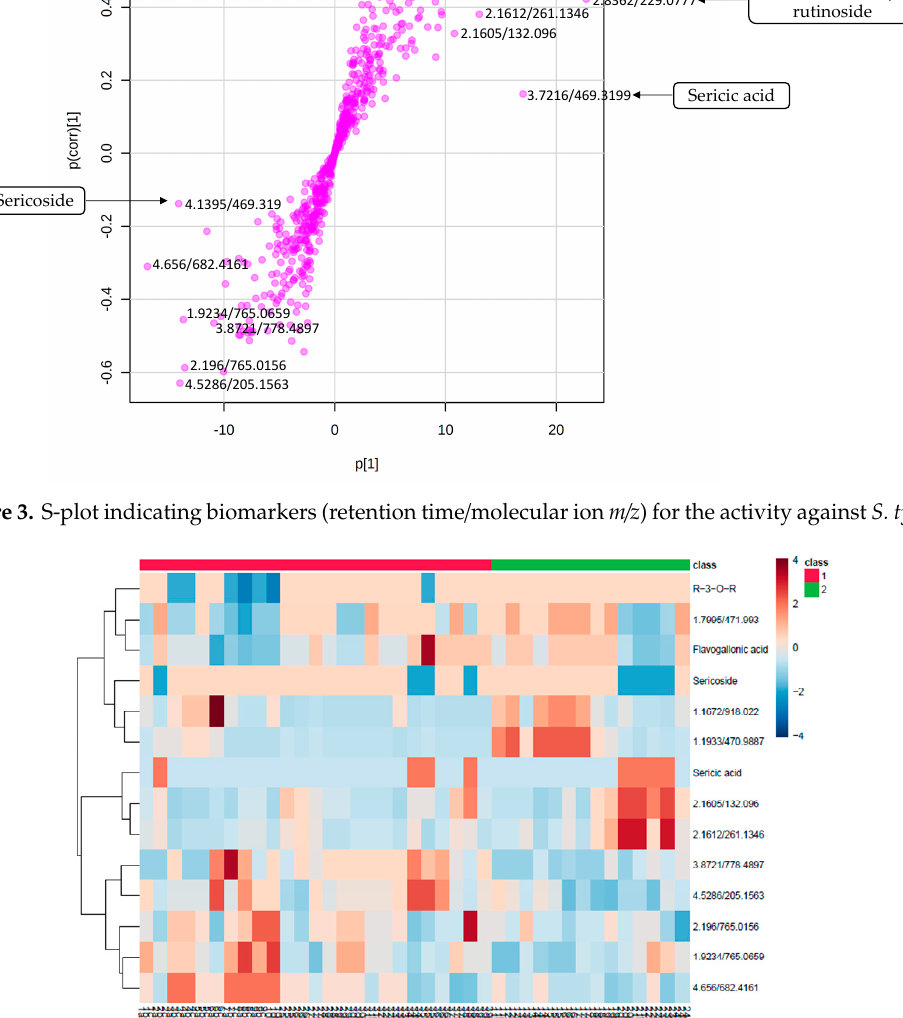
Figure 3. S-plot indicating biomarkers (retention time/molecular ion m/z ) for the activity against S. typhi.